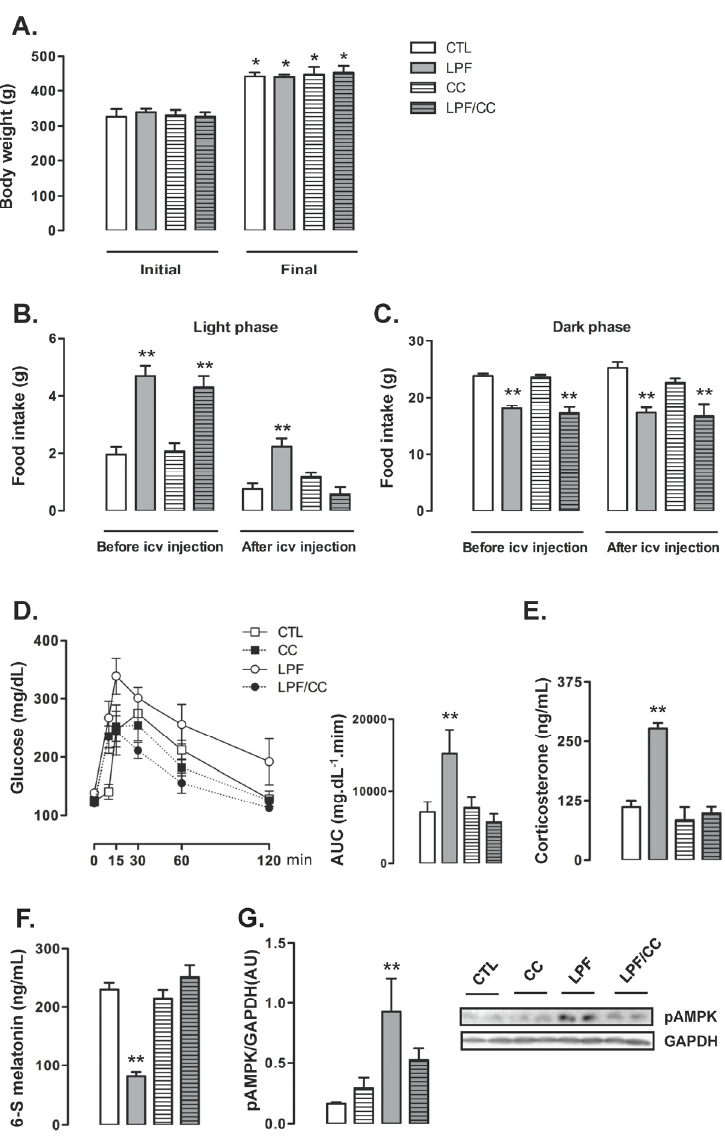
Figure 3. Pharmacological inhibition of adenosine monophosphate-activated protein kinase (AMPK) in the central nervous system of LPF rats. Rats were assigned to the groups control (CTL), Light Phase Fructose (LPF), Compound C (CC) and Light Phase Fructose with Compound C (LPF/CC). Cannula implantation and icv treatments (five days) occurred during the sixth and eighth weeks of fructose treatment, respectively. ( A ) Body weights were assessed before and after (8 weeks) fructose treatment. Food intake was assessed before and after icv injections during the last week of fructose treatment. Data were acquired separately during the ( B ) light and the ( C ) dark phases. After these measurements ( D ), the rats were subjected to glucose tolerance tests. Tests were performed two hours before “lights off” and area under the curve (AUC) was calculated. Euthanasia was performed two hours before lights off, and the hypothalamus and plasma were collected. ( E ) Plasma samples were used for corticosterone determinations. ( F ) Urine was collected overnight before euthanasia for determination of 6-S-Mel concentration. ( G ) Hypothalamus samples were used for Western blot detection of phosphorylated AMPK and normalization by Glyceraldehyde 3-phosphate dehydrogenase (GAPDH). The results are presented as the means ± standard error of the mean. * p < 0.05 vs. same group before fructose treatment; ** p < 0.05 vs. CTL at the same moment of icv treatment.